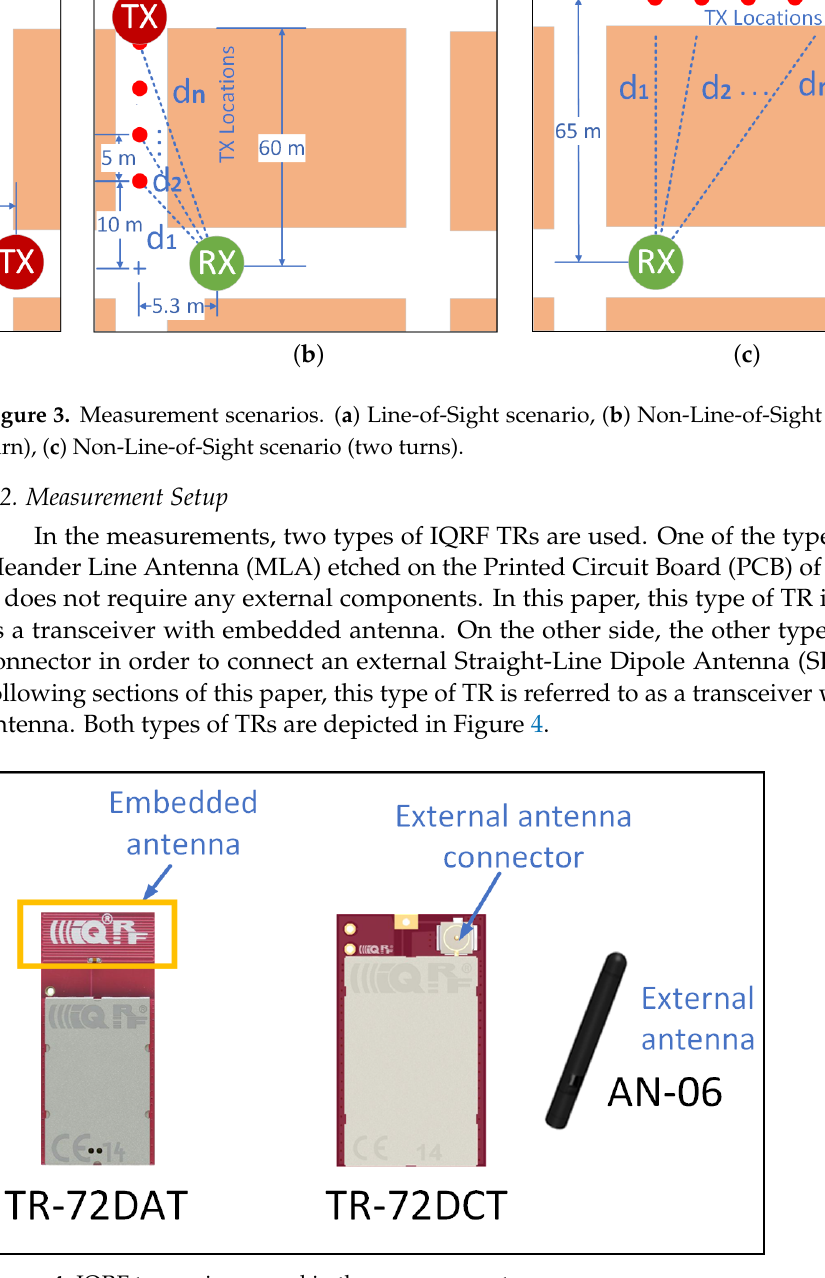
Figure 4. IQRF transceivers used in the